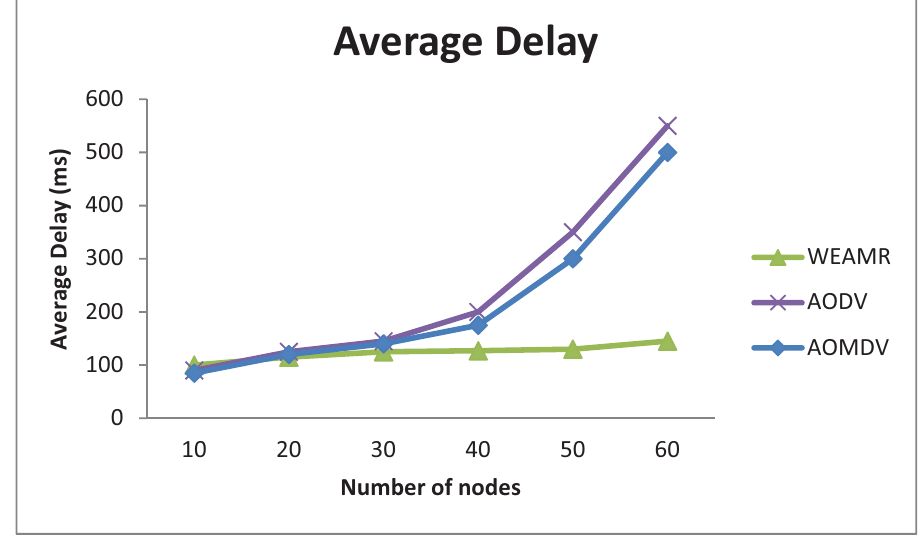
Figure 18. Average end to end delay with increasing number of